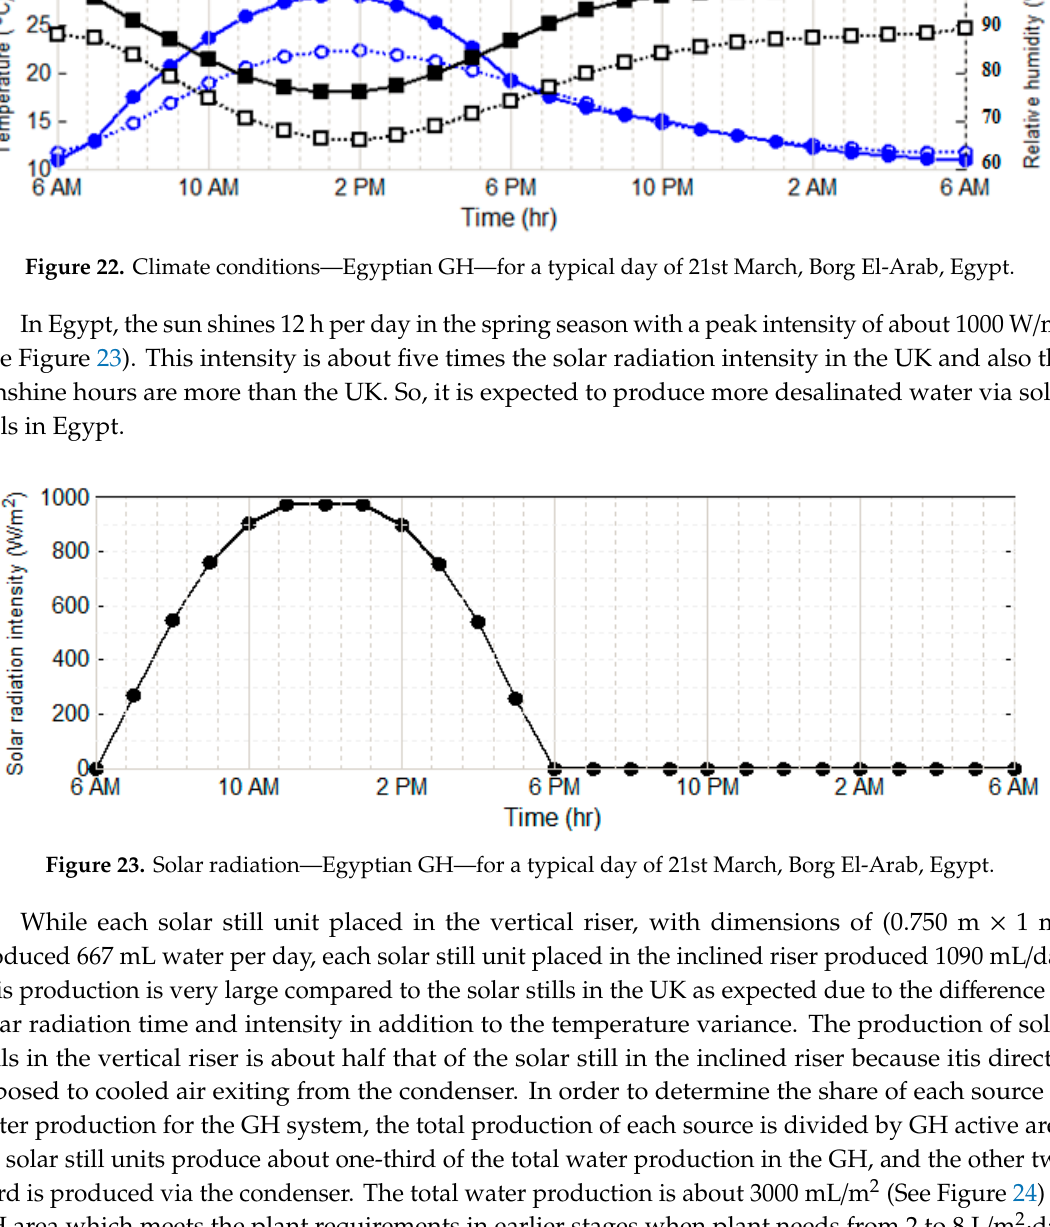
While each solar still unit placed in the vertical riser, with dimensions of (0.750 m × 1 m),